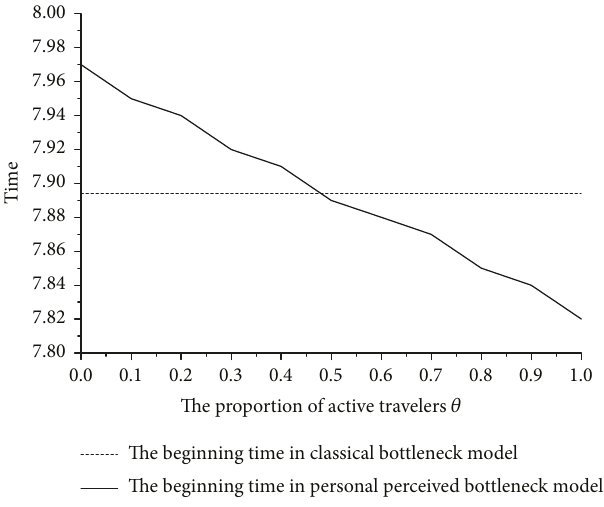
Figure 4: Changes of the beginning of rush hours with respect to the 𝜃 .